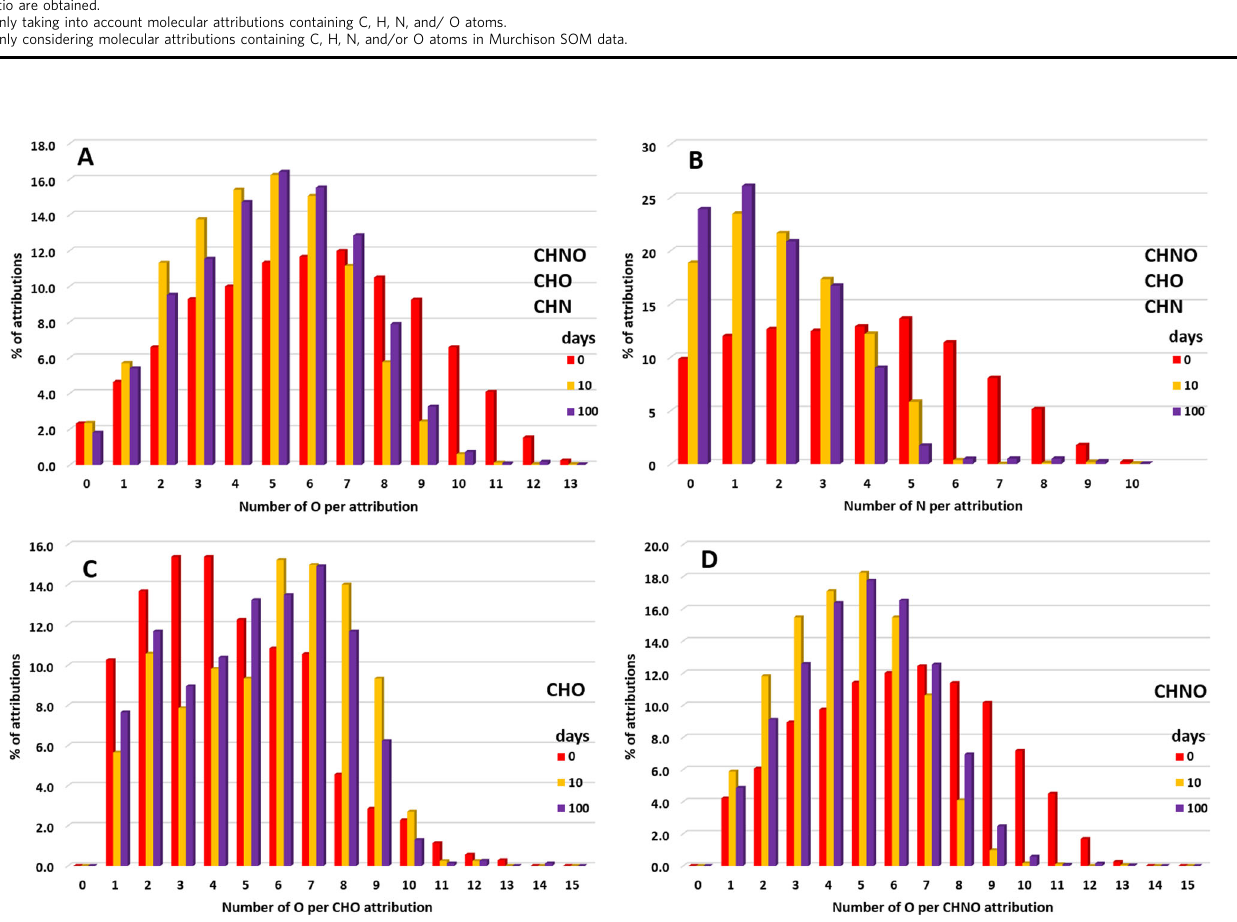
Fig. 2 Evolution of O and N atoms in Samples. Histograms of molecular attributions (%) per number of oxygen ( A ) or nitrogen ( B ) for all chemical families (CHO, CHN, and CHNO) for the pre-accretional organic residue and post-aqueous organic products after 10 and 100 days of aqueous reaction at 150 °C. Molecular attributions per number of O for CHO ( C ) or CHNO ( D ) families are also